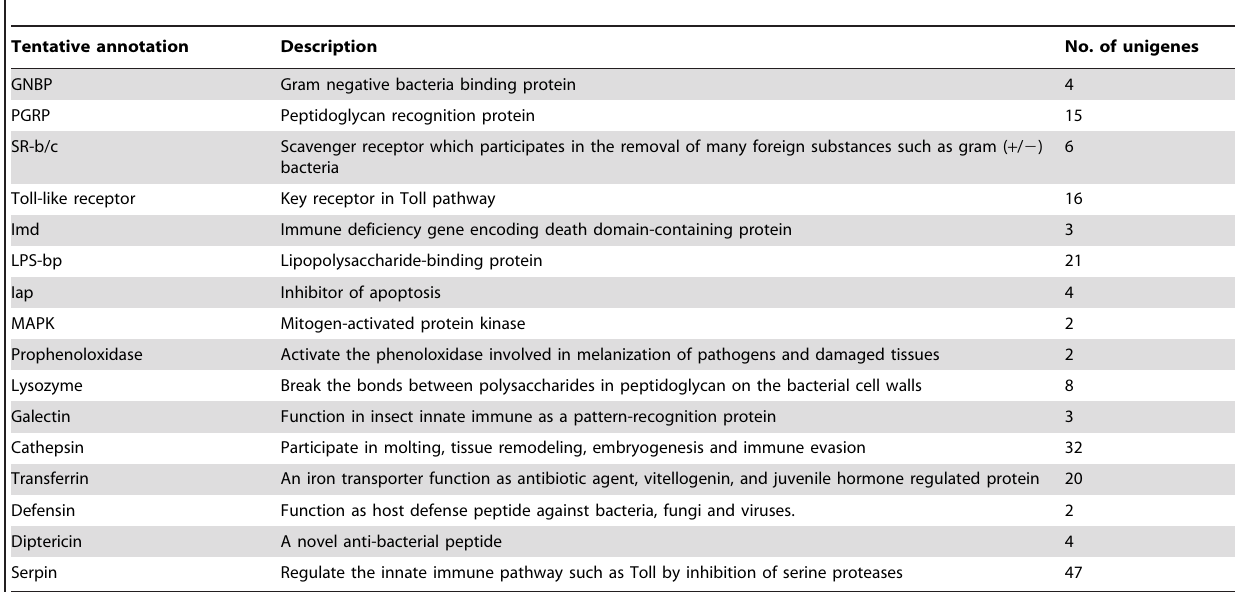
Table 4. Genes related to innate